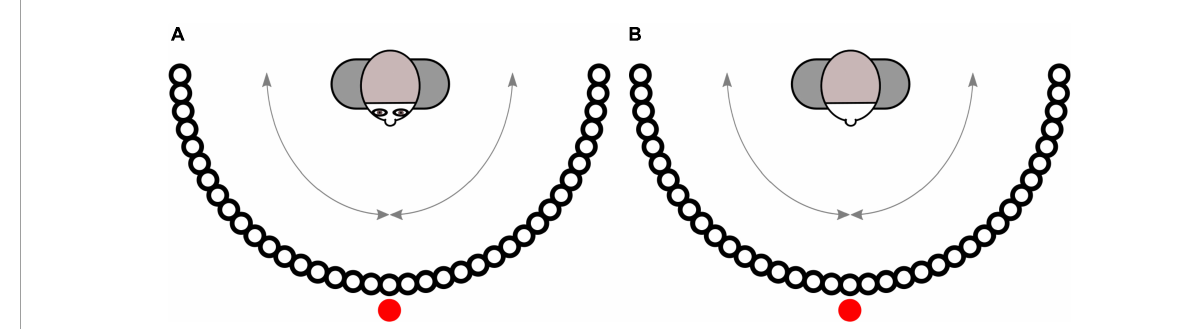
FIGURE3 Svg-graphics for the assessment of gaze direction (A) and head orientation (B) .